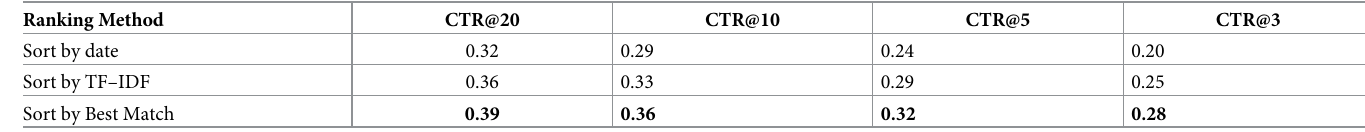
Table 1. Comparison of the user click-through rate of best match versus the previous TF–IDF method and the default date sort order. Ranking Method Sort by date 0.32 0.29 0.24 Sort by TF–IDF 0.36 0.33 0.25 Sort by Best Match 0.39 0.36 0.32 0.28